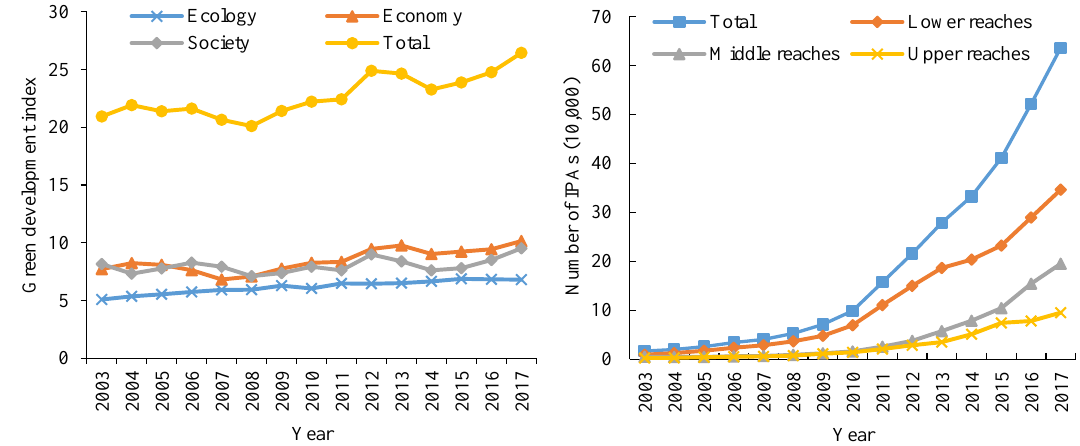
Figure 3. Evolution characteristics of urban technological innovation capability and GDL from 2003 to 2017. IPAs: invention patent applications.